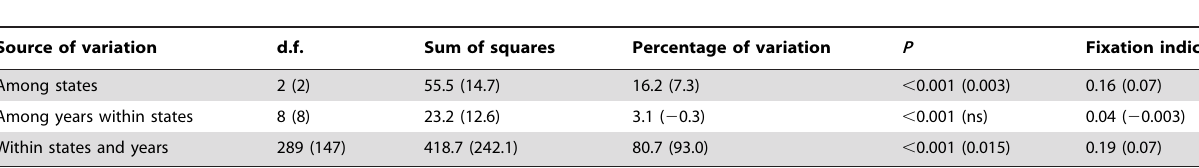
Table 2. Analysis of molecular variance (AMOVA) among California, Oregon, and Washington samples.